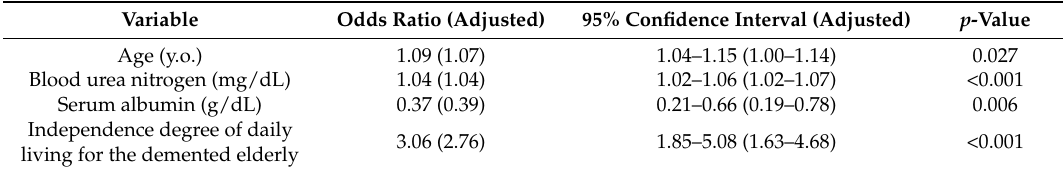
Table 5. Relationship between numerical data and prognosis (multivariate